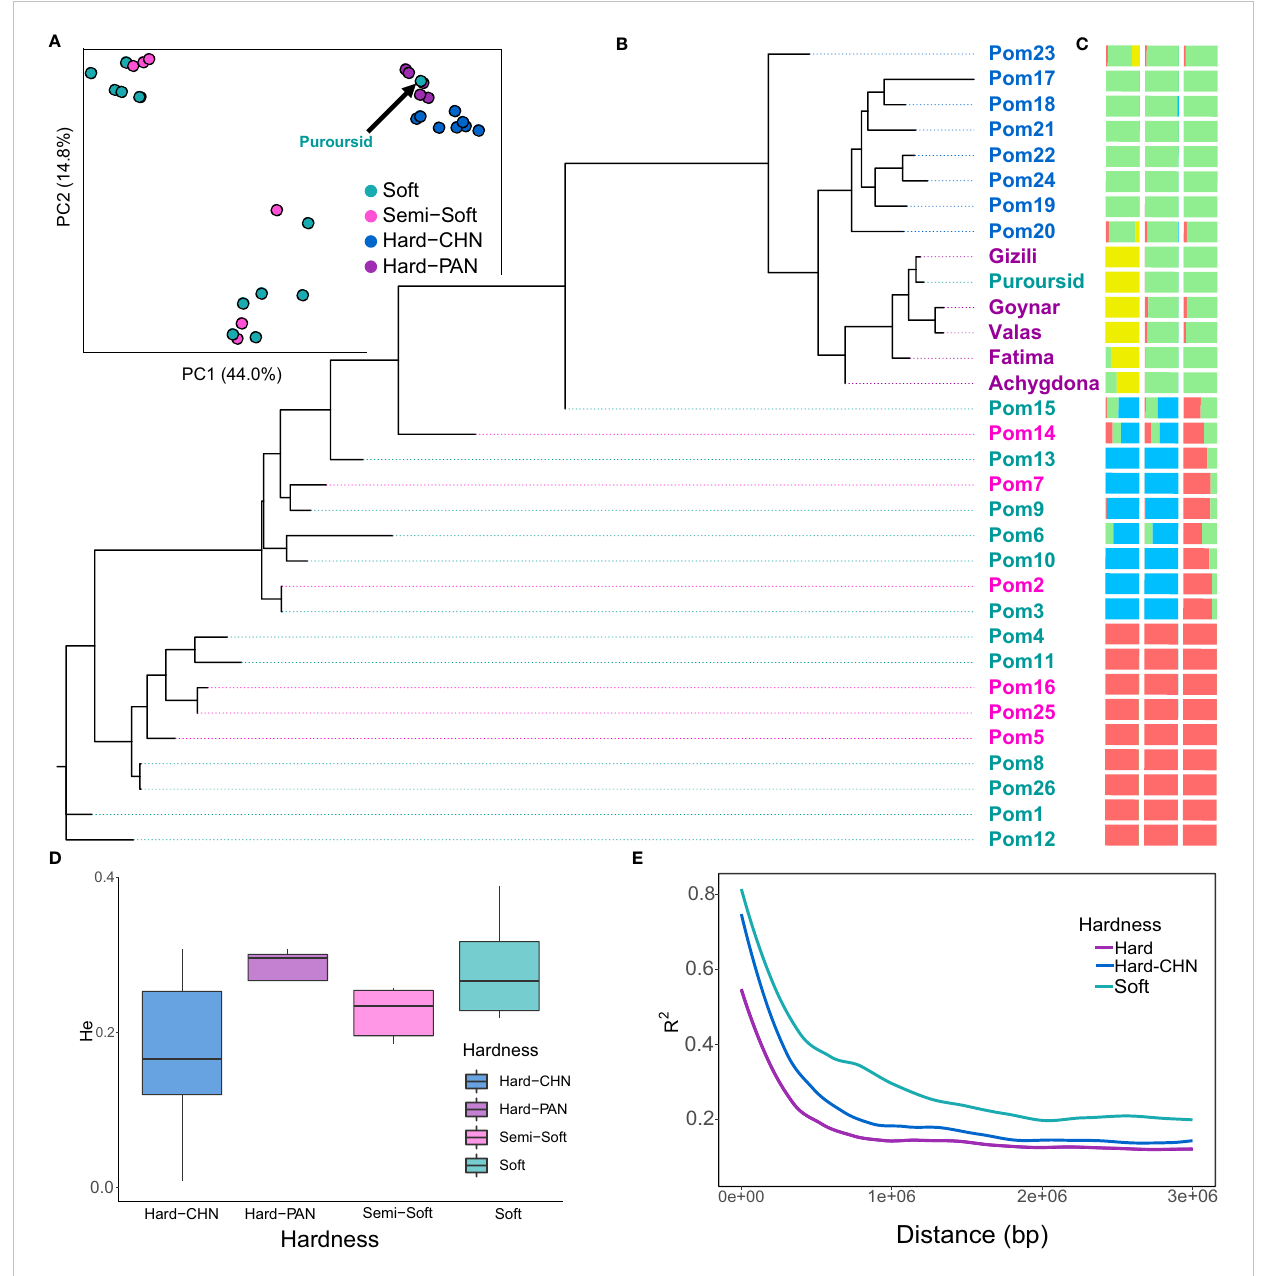
FIGURE 3 The population genetics of the re-sequenced cultivars. (A) the principal component analysis for the whole populations; (B) the phylogenetic tree for all cultivars; (C) the ADMIXTURE analysis at K = 2 (right), K = 3 (middle), and K = 4 (left); (D) the heterozygosity variation in different subpopulations; (E) linkage disequilibrium decay for different